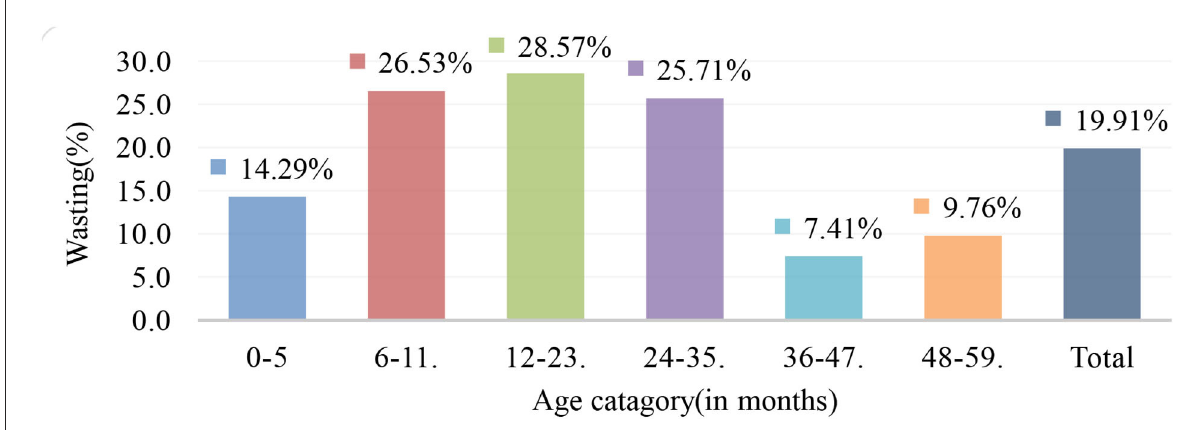
FIGURE1 Prevalence of acute malnutrition (wasting) by age category among under-five children in Shashemene district, Oromia region, Ethiopia, July